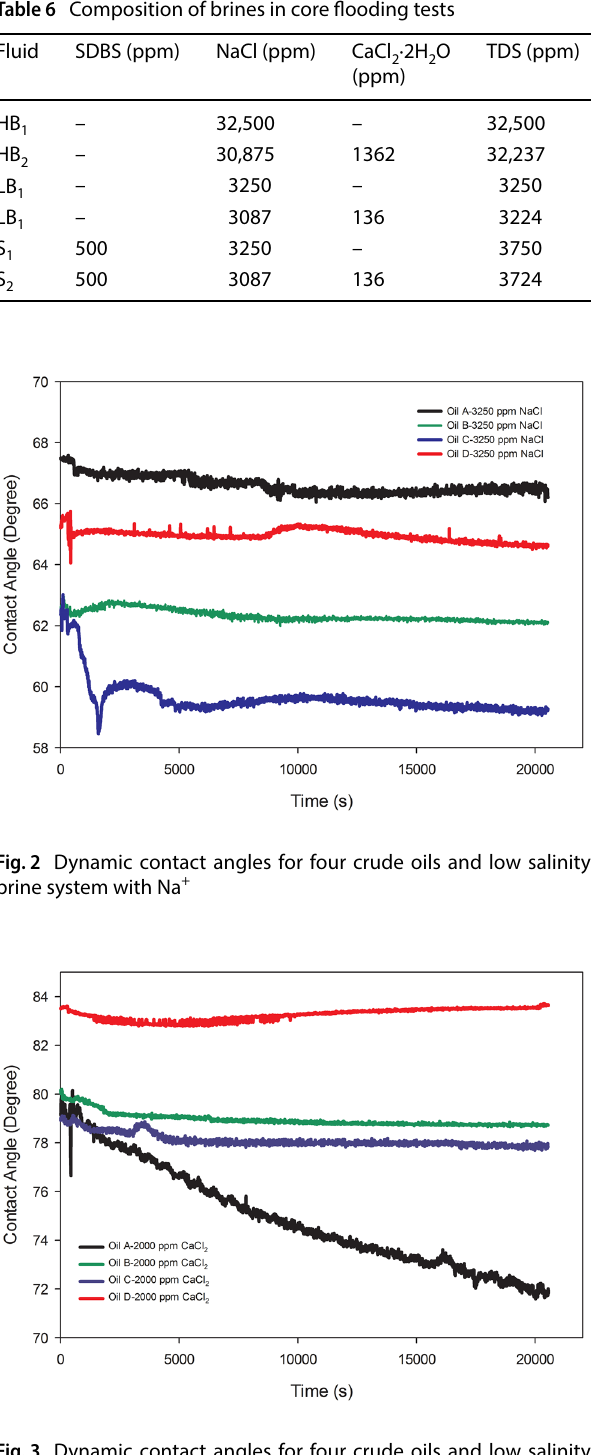
Fig. 3 Dynamic contact angles for four crude oils and low salinity brine system with Ca 2+